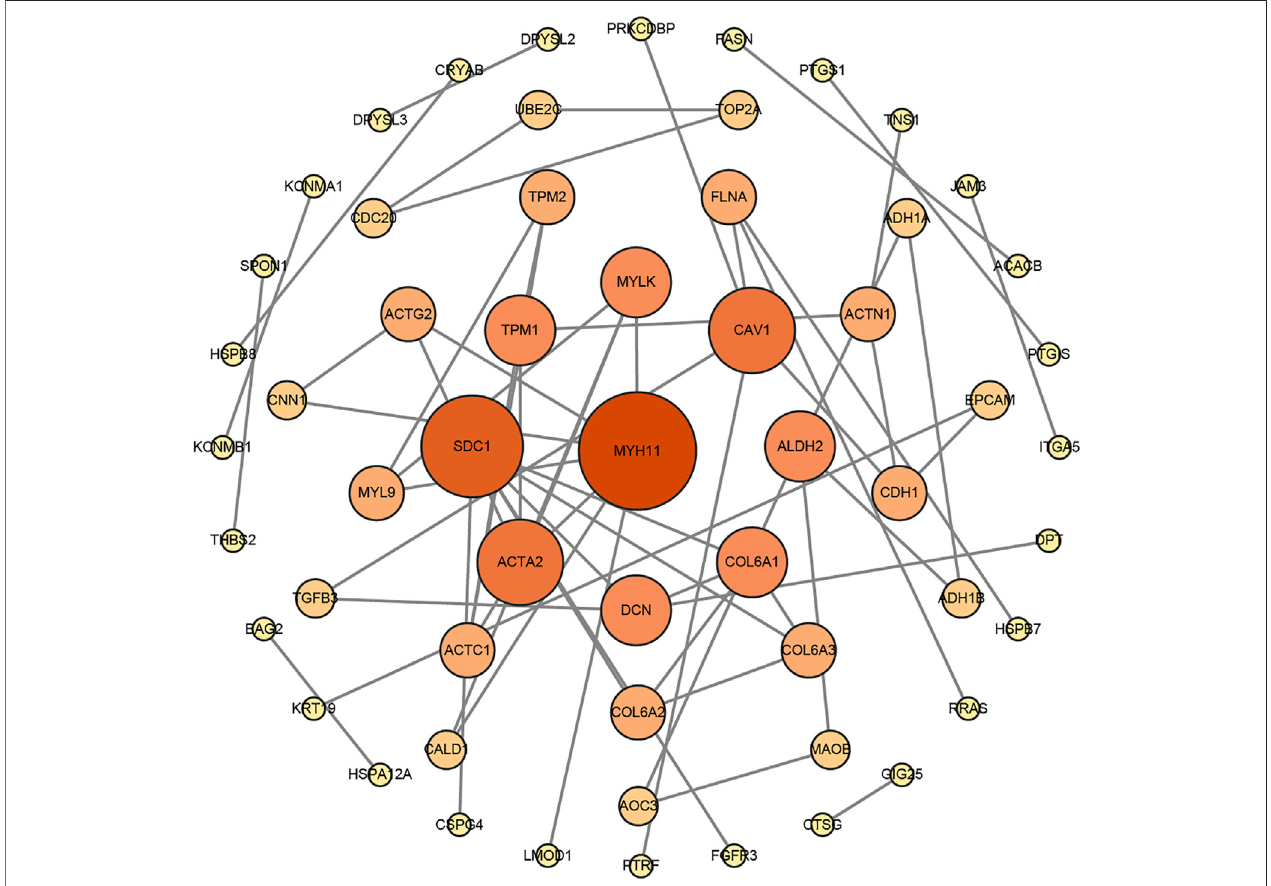
FIGURE 5 | The protein – protein interaction (PPI) network of DEGs was constructed by the STRING website tools and modi fi ed by Cytoscape Software.